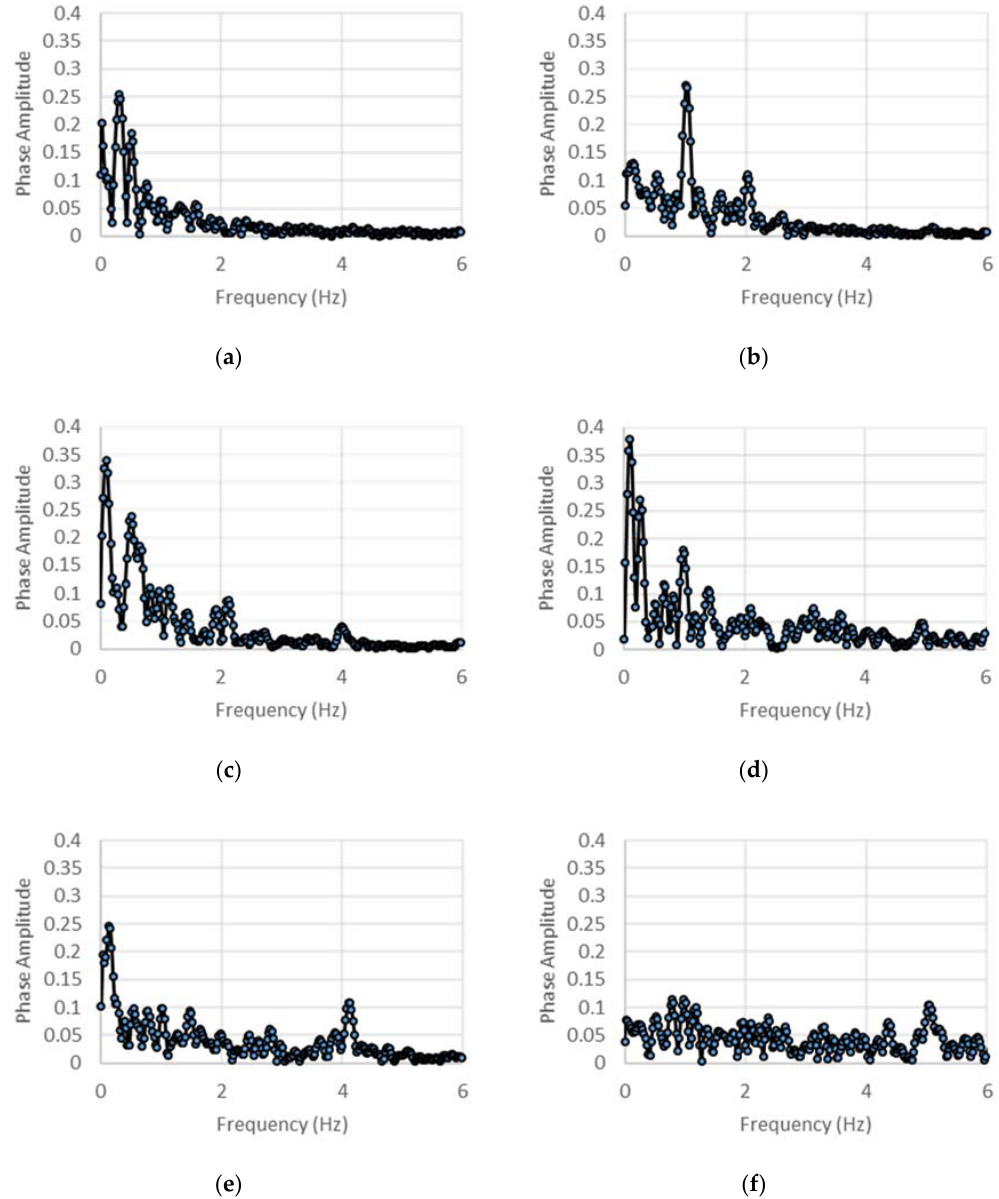
Figure 20. Phase angle spectra for ( a ) 0.5 Hz, ( b ) 1 Hz, ( c ) 2 Hz, ( d ) 3 Hz, ( e ) 4 Hz, and ( f ) 5 Hz for displacement